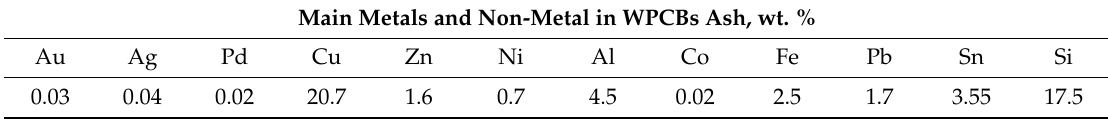
Table 1. The chemical composition of the waste printed circuit boards (WPCBs) ash sample.